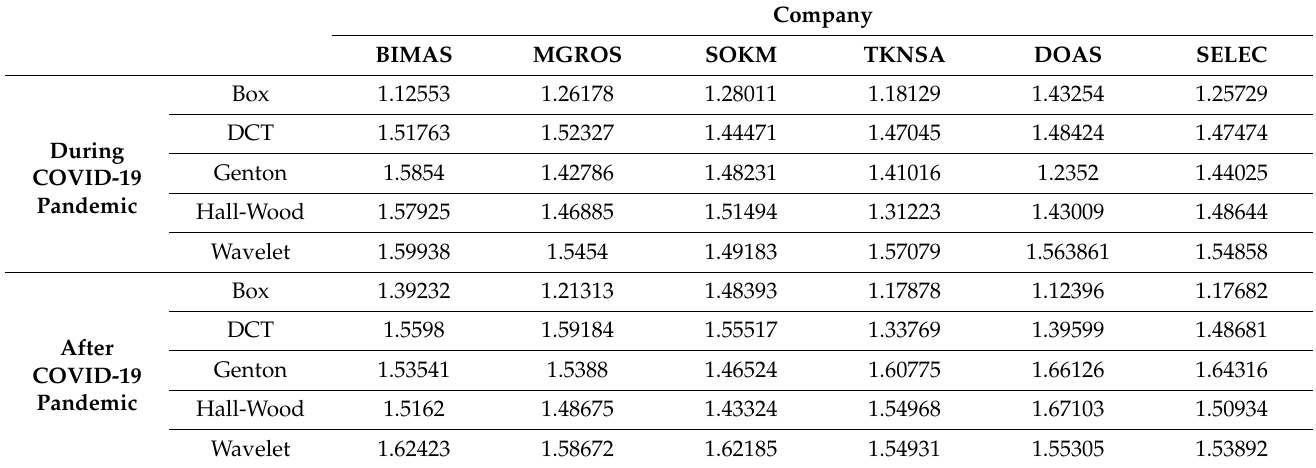
Table A13. Fractal dimensions for the wholesale–retail sector.